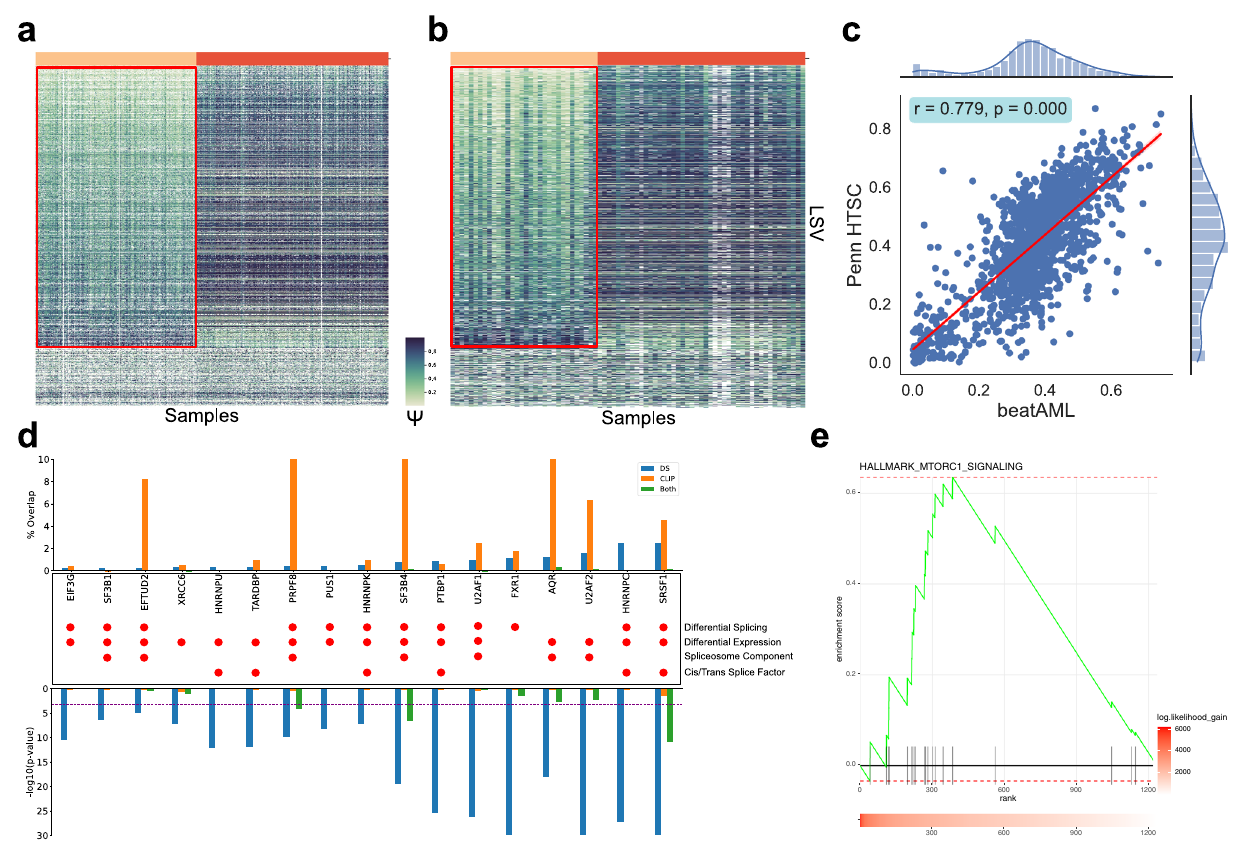
Fig. 3 | BeatAML Dataset Analysis. a Heatmap showing the tile discovered by CHESSBOARD on the beatAML dataset (samples=477, LSVs=2299). The signal (samples=217, LSVs=1910) is outlined in red. Note that although CHESSBOARD was run on junction spanning read rates as input, the heatmap shows Ψ values to facilitate visualization. b Heatmap of Ψ values in the Penn HTSC dataset (sam- ples=77, LSVs=2299), showing reproducibility of the tiles originally identi fi ed by CHESSBOARD in the beatAMLdataset.The signal tile(samples=32,LSVs=1899)is outlined in red. c Correlation between median ( ΔΨ ) in the beatAML and HTSC datasets for the representative junction in each LSVs belonging to the tile. The median ( ΔΨ ) value was computed between the 2 groups discovered by CHESS- BOARD in both datasets. Correlation is measured using Pearson ’ s correlation coef fi cient ( r ) and the two-sided p value is the probability of observing a coef fi - cient> ∣ r ∣ undertheexactnulldistribution. d ENCODEbasedanalysisofpossibletile regulators.Topbarplotshowsthepercentageof splice junctions( y -axis)inthetile